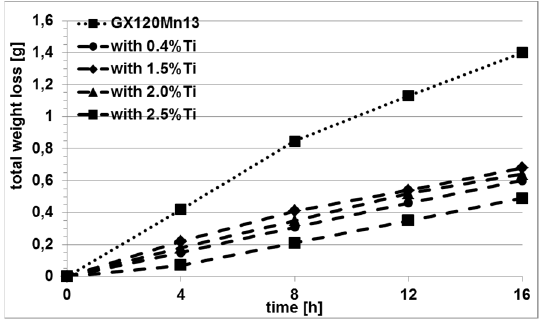
Figure 7. Abrasive wear response of Hadfield cast steel vs. high-manganese cast steel with the addition of 0.4–2.5% Ti, [8].